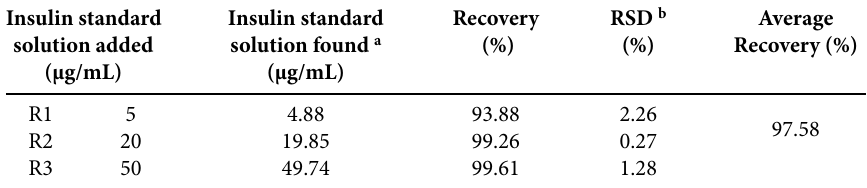
Table 4. Determination of the recovery of the analytical method for insulin in